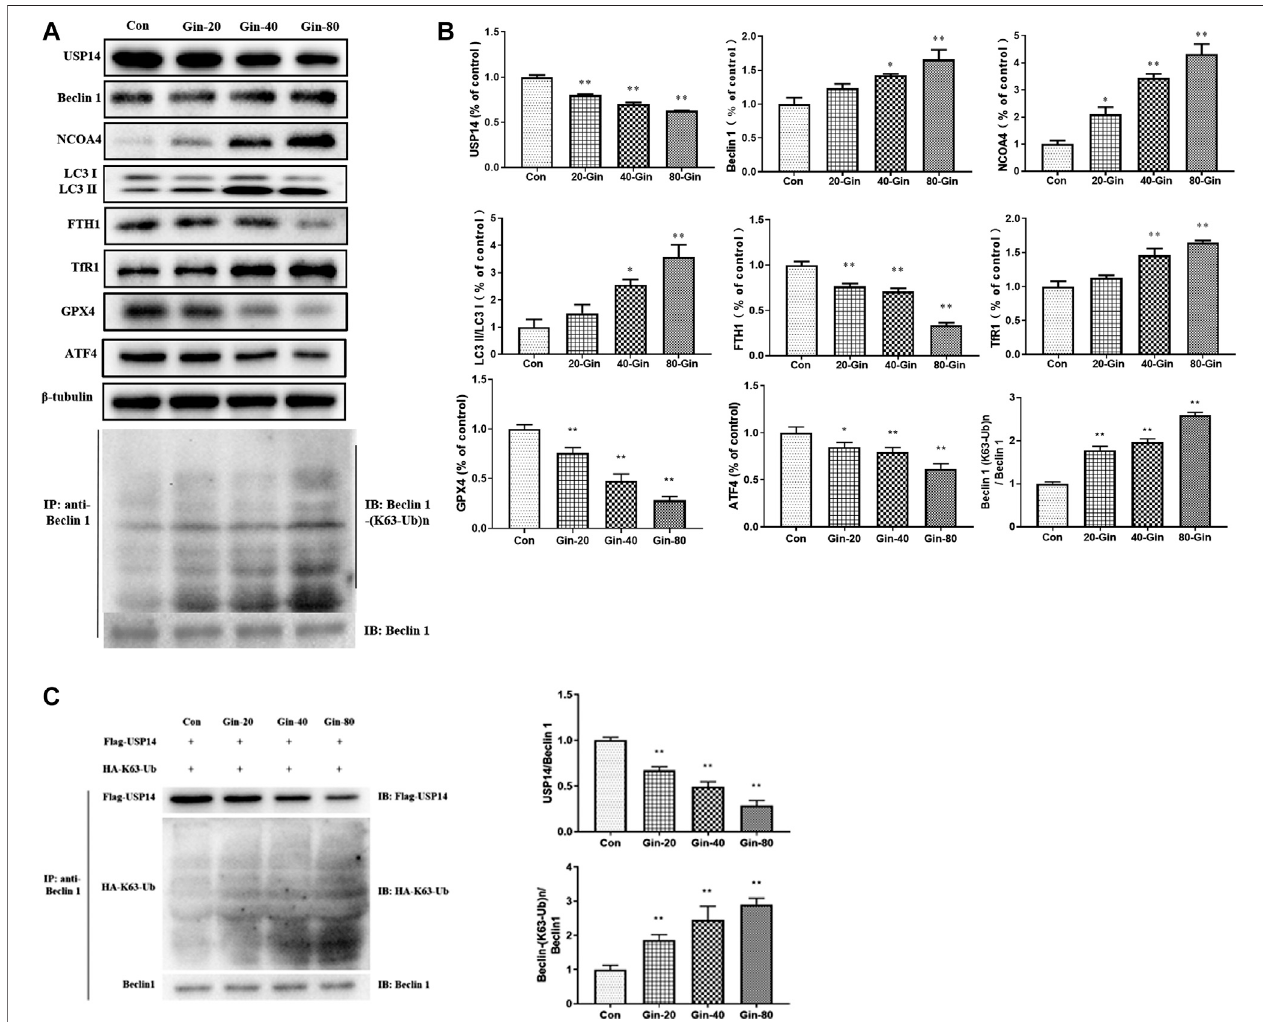
FIGURE 6 | 6-Gingerol regulates the expression of autophagy and ferroptosis related proteins in A549 cells. (A) The western blot analysis of USP14, Beclin 1, NCOA4,LC3I,LC3II,FTH1,TfR1,GPX4and ATF4,Co-IPanalysisofubiquitinationofK63onBeclin one; (B) Thedensitometric analysisofthebandswaspresentedas therelative ratioofUSP14,Beclin1,NCOA4, LC3II/LC3 I,FTH1,TfR1,K63ubiquitinationonBeclinonetoBeclin1. (C) Invitro K63-linkeddeubiquitinationofBeclin one byUSP14.Con: control,20-Gin:20 μ M6-Gingerol,40-Gin:40 μ M6-Gingerol,80-Gin:80 μ M6-Gingerol.Compared withthecontrolgroup, * p < 0.05,** p < 0.01. Data are expressed as mean ± SD ( n (cid:2)